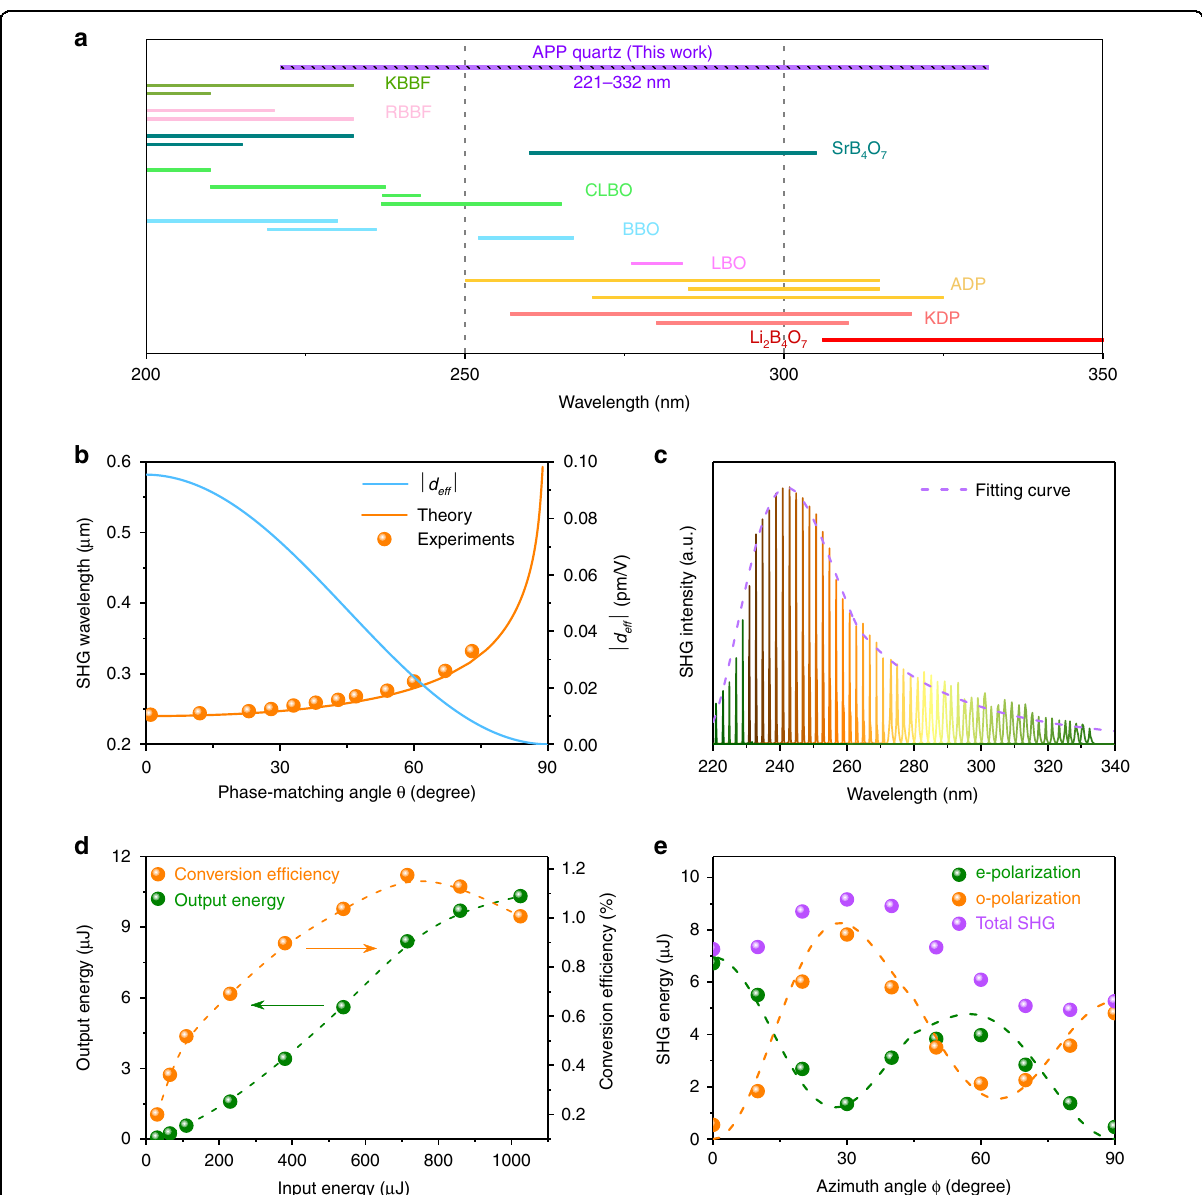
Fig. 4 Experimental demonstration of angular APP phase matching with APP quartz with a period of L a ¼ L b ¼ 2 : 1 μ m. a Comparison of the tunable spectral region of this work with those of common nonlinear optical crystals in the deep-UV (200 – 350 nm) range. b Calculation of the angular APP phase-matching angle θ and distribution of absolute value | d eff | in the YZ plane when ϕ = 90°. The dots are the experimentally measured phase-matching angles corresponding to SHG wavelengths. c SHG signal intensities at different wavelengths from 221 to 332 nm. The dashed line is the fi tting curve of SHG intensities. d Output energy and conversion ef fi ciency of the SHG light at 242 nm. e Calculated (curves) and experimental (dots) SHG intensities for ordinary and extraordinary light at 250 nm with azimuth angle ϕ tuning from 0° to 90° along the Z direction, where the phase-matching angle is located at θ =